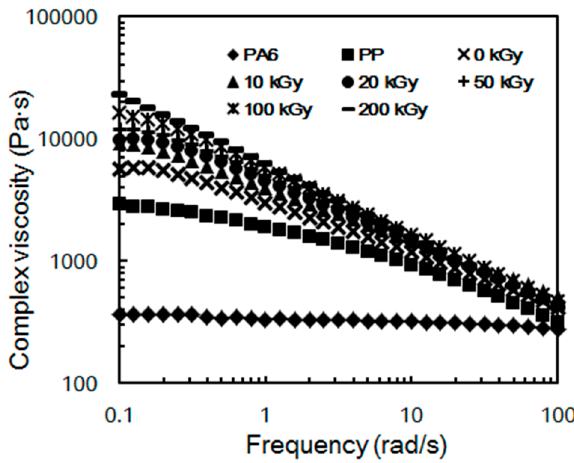
Figure 3. Complex viscosities of PA6/PP (80/20) blends irradiated at different dosages as a function of frequency at 235 °C.